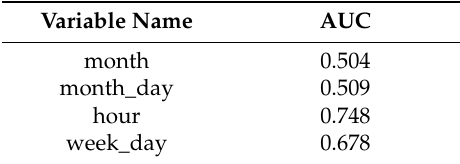
Table 3. AUC values for the categorical variables used to detect 99th percentile peaks.